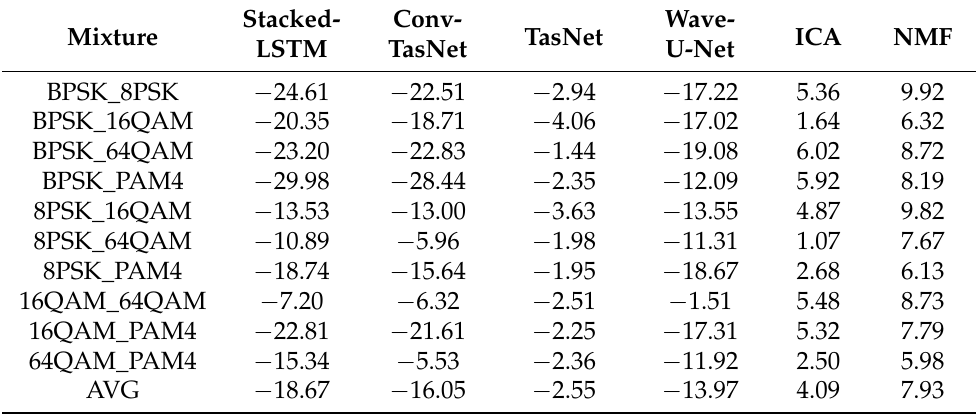
Table 3. Loss of different algorithms on 20 dB mixture